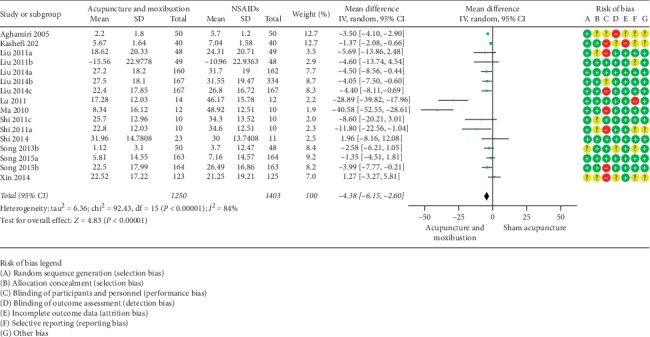
Acupuncture and moxibustion vs. sham acupuncture.